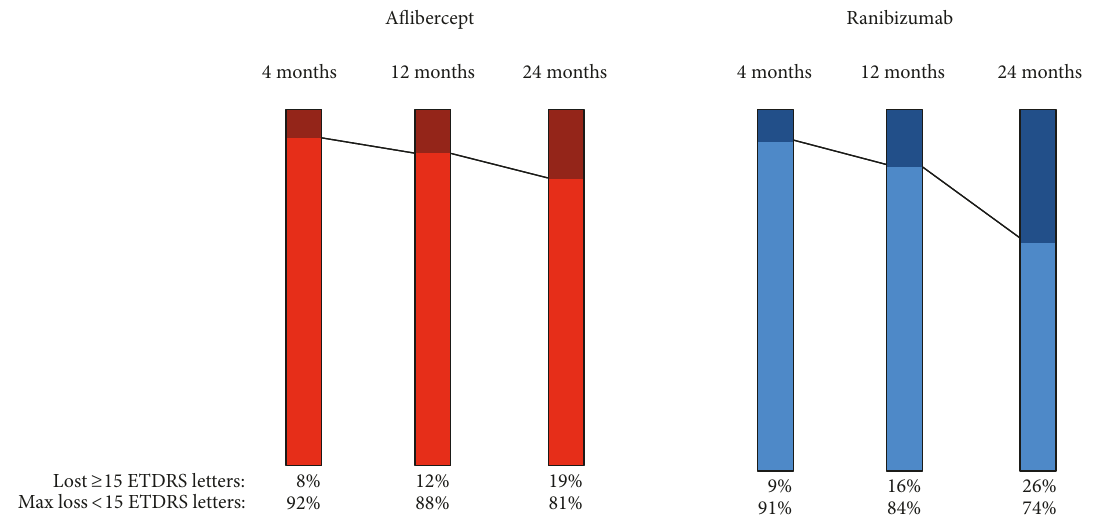
Figure 3: Rate of patients with neovascular age-related macular degeneration aged ≥ 90 years that experience a loss of ≥ 15 ETDRS letters in best-corrected visual acuity during treatment with either A fl ibercept (red) or Ranibizumab (blue).